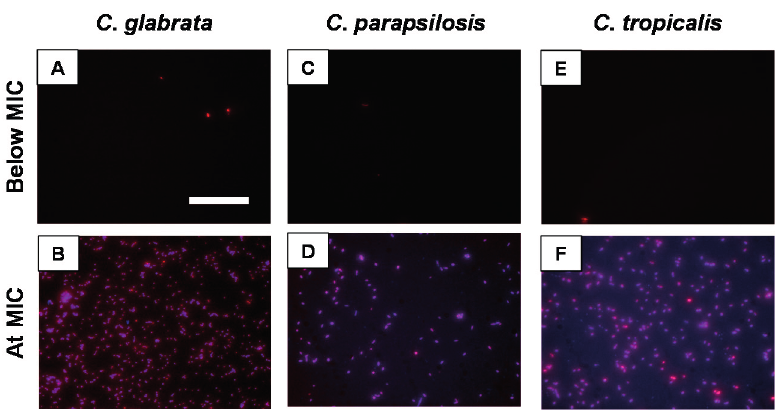
Figure 3. Fluorescence micrographs of C. glabrata ( A , B ), C. parapsilosis ( C , D ), and . Cells (10 5 cells/mL) were treated with peptide C. tropicalis ( E , F ) treated with peptide 4 FL 4 (blue) at a concentration 4-fold below the MIC ( A , C , E ) and at the MIC ( B , D , F ) FL